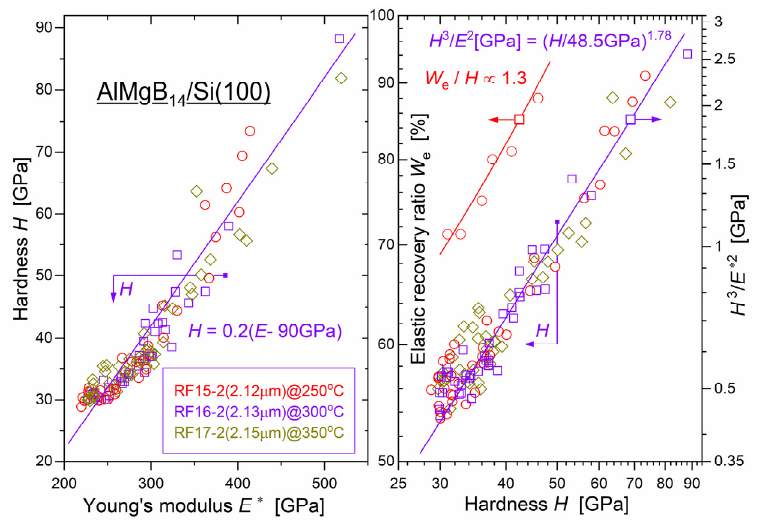
Figure 6. Left frame–hardness H vs. elastic modulus E ∗ measured at di ff erent loading forces. Right frame–resistance to plastic deformation ratio H 3 / E ∗ 2 and elastic recovery ratio W e vs. hardness H in the log-log scale.